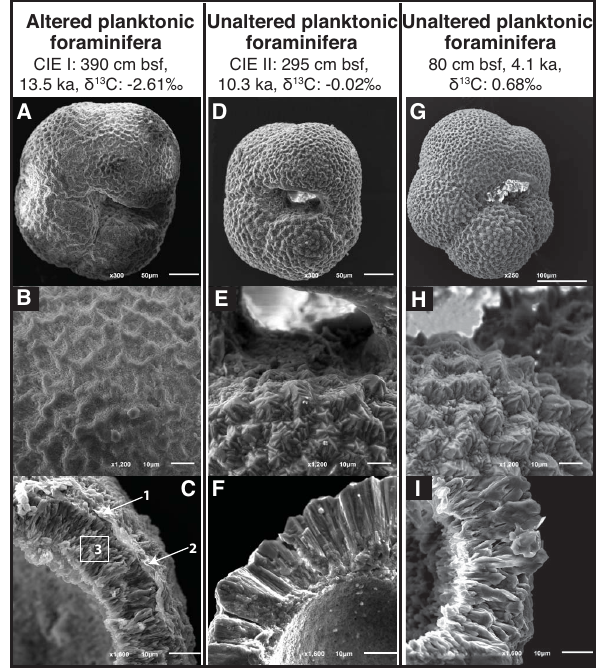
Figure 6. Representative SEM images of uncleaned N. pachyderma (s) specimens from different intervals: (a, b, c) from 390cmbsf, (d, e, f) from 295cmbsf, and (g, h, i) from 80cmbsf. (a) N. pachy- derma (s) test from the most depleted interval within CIE I ( δ 13 C: − 2.61‰, 13.5ka, 390cmbsf) showing a test with surface alter- ation. (b) Detail of picture (a) with clearly altered external sur- face. (c) Broken test of a different specimen of N. pachyderma (s) from the same interval, where a thin deposited layer (methane- derived coating) unevenly covers the external text, whereas the foraminiferal wall shows a pristine structure with pristine crystal palisades. The numbers in the picture indicate EDS analyses in Fig. 7. (d) N. pachyderma (s) from CIE II interval ( δ 13 C: − 0.02‰, 10.3ka, 295cmbsf) showing an unaltered test. (e) Detail of pic- ture (d) with pristine shell structure. (f) Detail of the wall structure with pristine crystal palisades from a different specimen in the same interval. (g) N. pachyderma (s) from interval with normal 13 C val- ues ( δ 13 C: 0.68‰, 4.1 ka, 80cmbsf) showing a well-preserved test with pristine shell structure. (h) Detail of picture (g) with pristine crystals shape. (i) Detail of the wall structure with pristine crystal palisades from a different specimen in the same interval. Picture magnifications and length of the white bar are indicated in each pic-